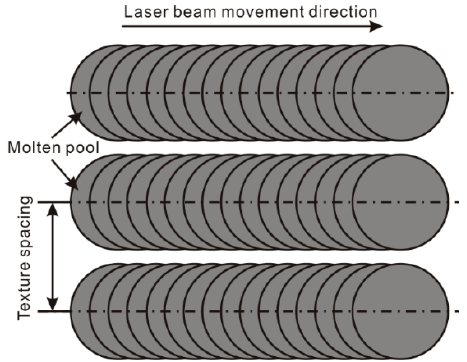
Figure 9. Schematic of overlap degree of melting zone.